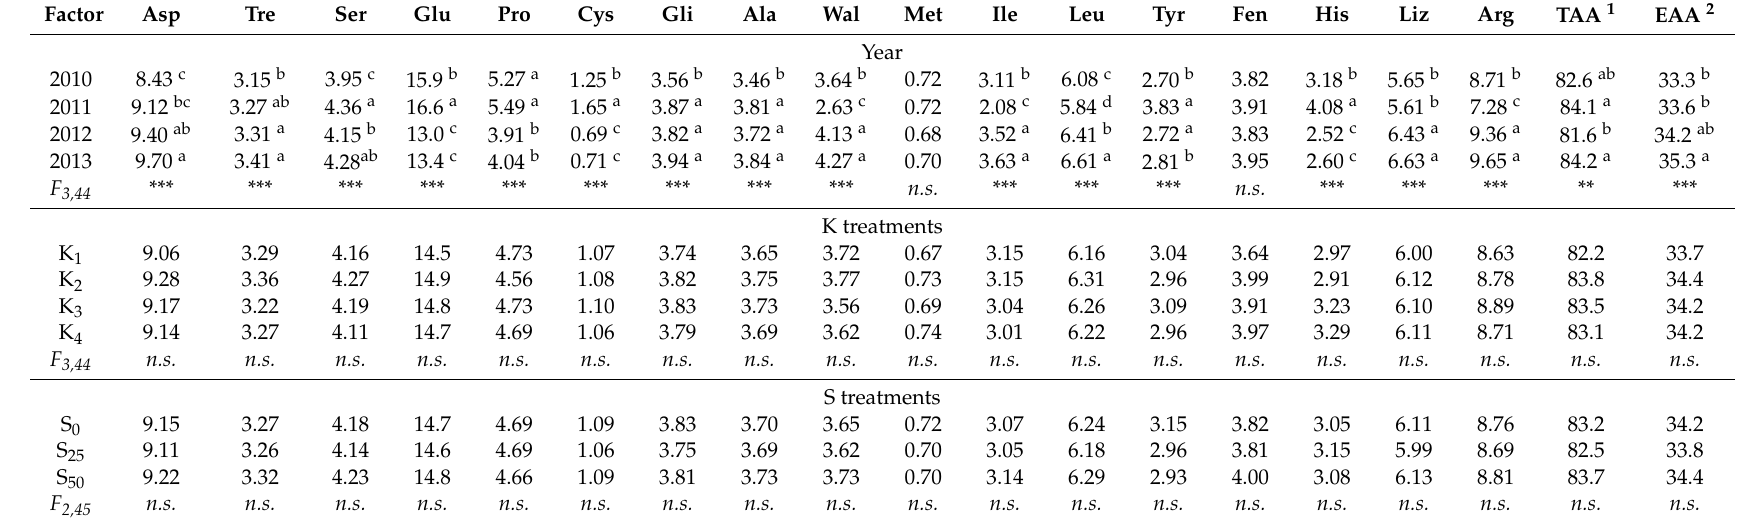
Table 6. E ff ect of growing season, K treatment, and S application on amino acid composition of mature seeds (MS) of faba bean (g 100g − 1 of CP). Factor